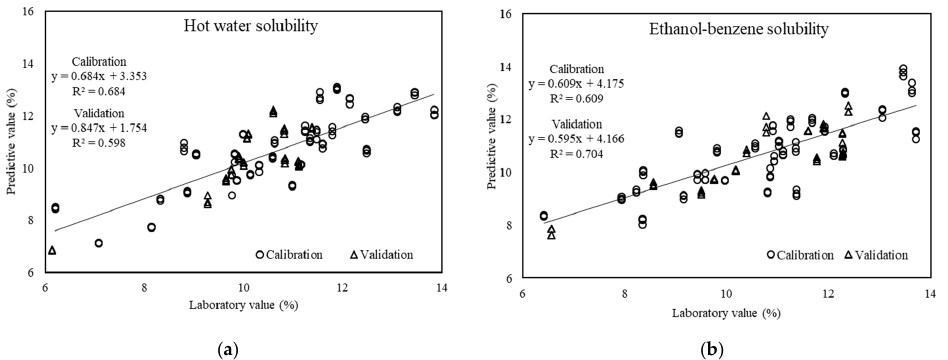
Figure 6. Linear regression models of predicted and laboratory values of ( a ) hot water soluble extractives, and ( b ) ethanol–benzene soluble extractives of ebony wood.